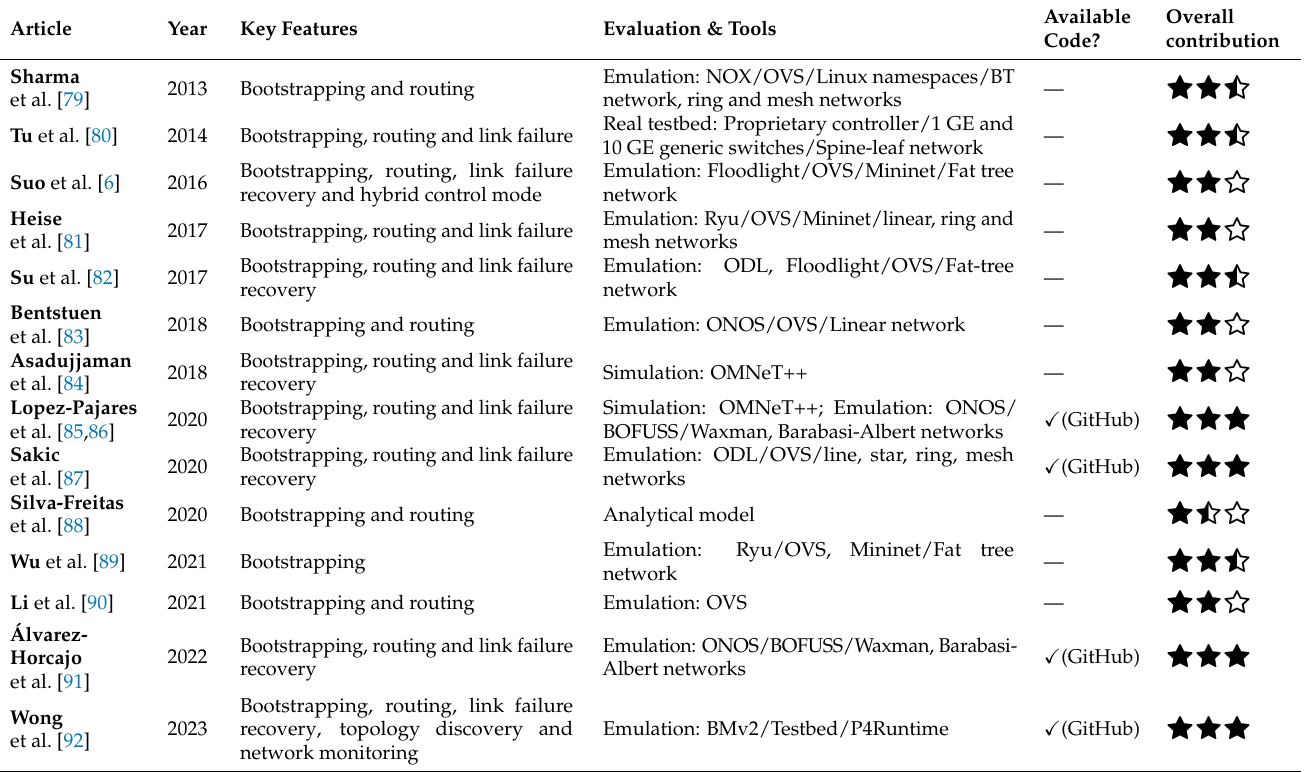
Table 4. Summary table of in-band proposals that support network